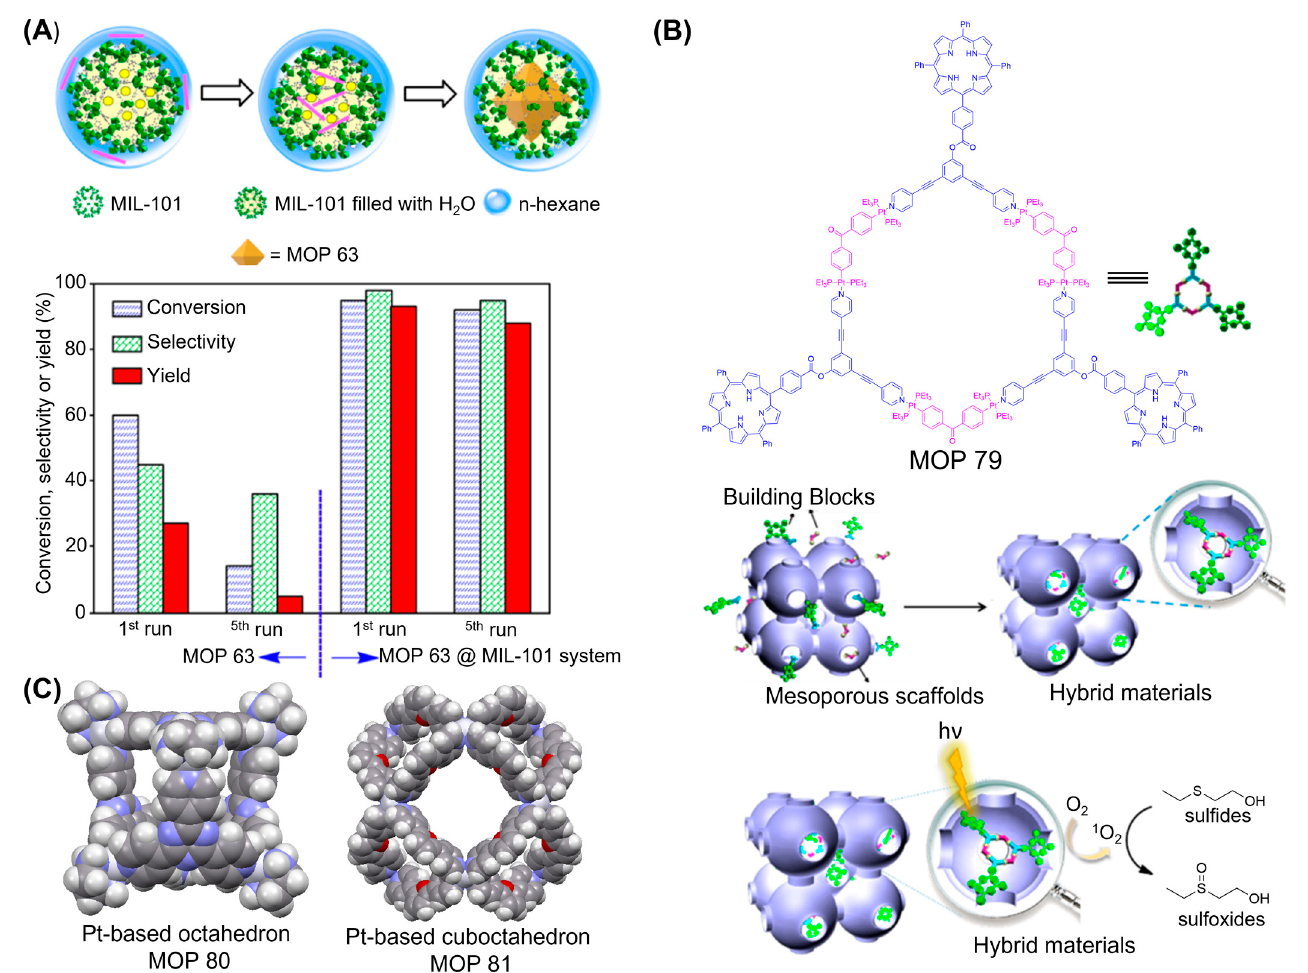
Figure 26. ( A ) Preparation of MOP 63 inside metal organic frameworks, MIL-101 is demonstrated. Catalytic performance and reusability of the MOP 63 and MOP 63 ﬤ MIL-101-4 materials in benzyl alcohol oxidation are reported. ( B ) Chemical and cartoon representation of MOP 79. Schematic presentation of self-assembly of porphyrin metallacycle MOP 79 in cavities of mesoporous carbon FDU-16. Scheme for the oxidation of sulfides (Hybrid materials as catalyst). ( C ) X-ray crystal struc- tures of Pt-based octahedron MOP 80 and Cuboctahedron MOP 81. Reprinted by permission from Refs. [208–211]. Copyright 1998, 2011, 2016 and 2018 from American Chemical Society.